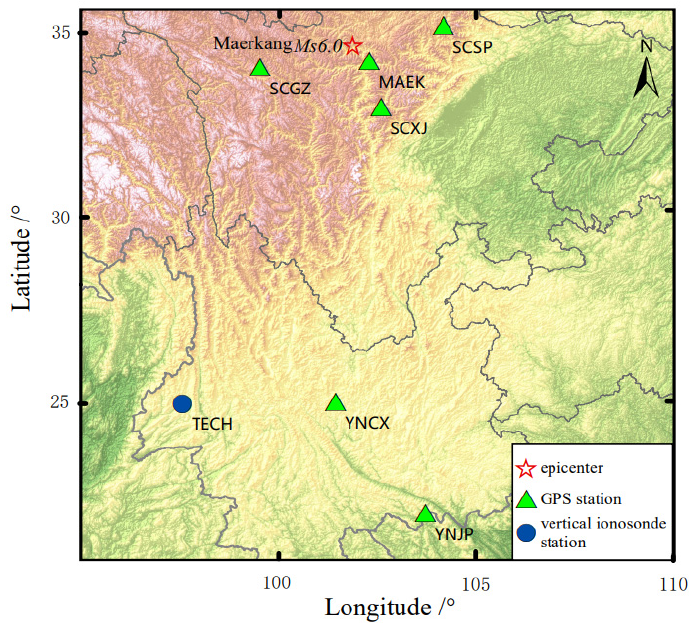
Figure 2. Distribution of epicenter and stations. The red star represents epicenter, green triangle and blue circle represent GPS and vertical ionosonde stations, respectively.